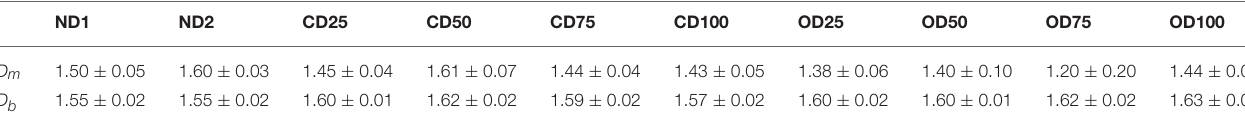
TABLE 2 | The fractal mass dimensions D m and box dimensions D b for the breakthrough patterns. ND1 ND2 CD25 CD50 CD75